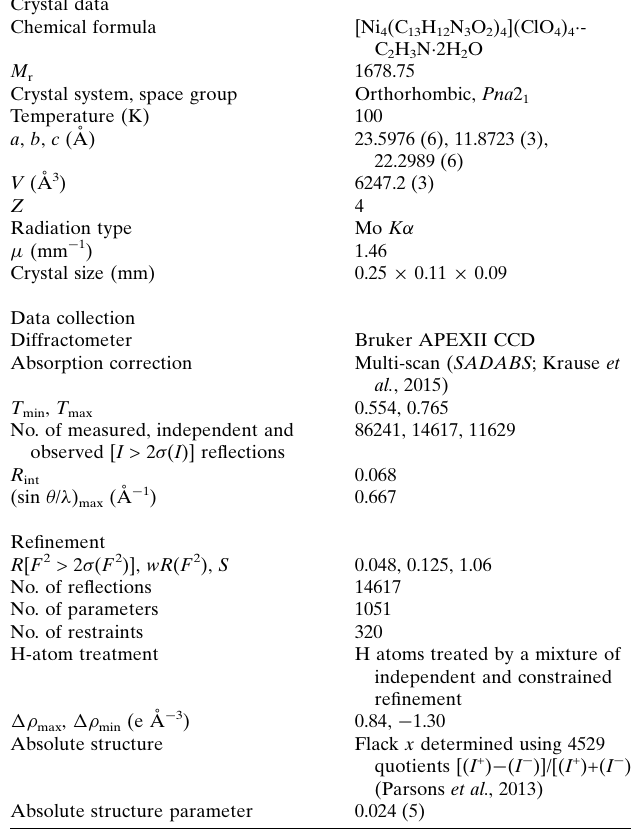
Table 3 Experimental details. Crystal data Chemical